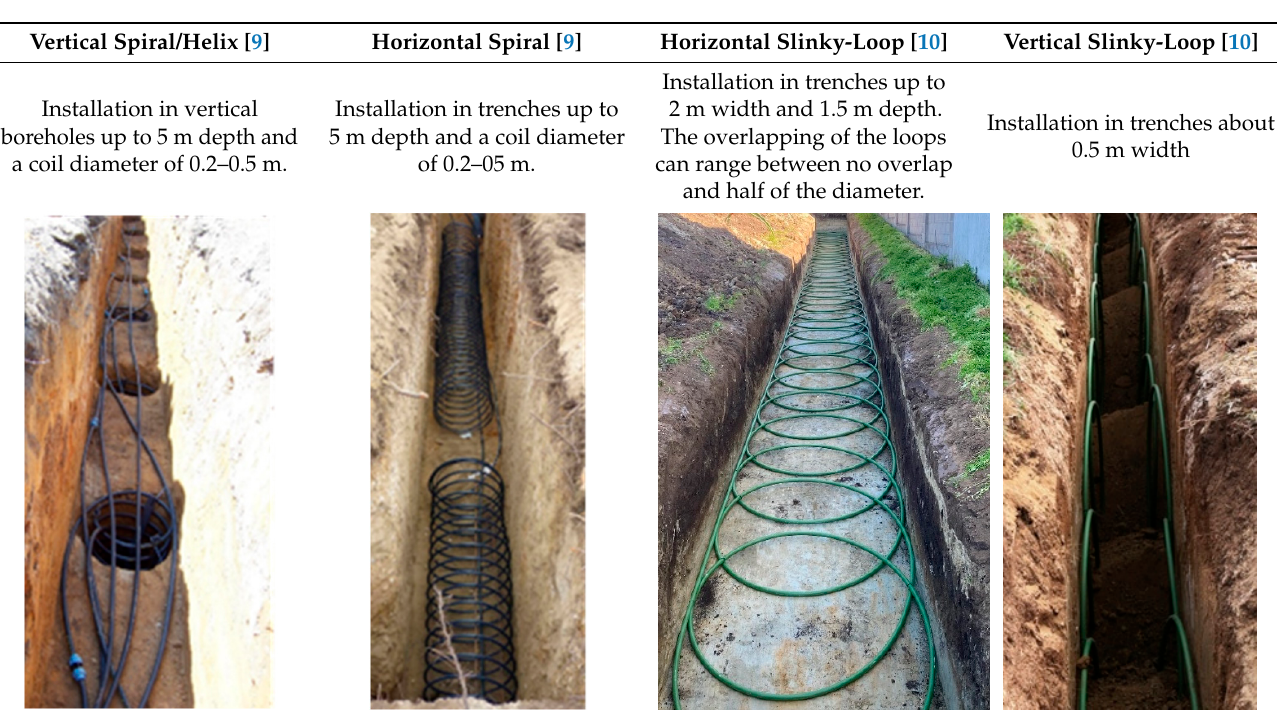
Table 1. Shallow heat exchanger